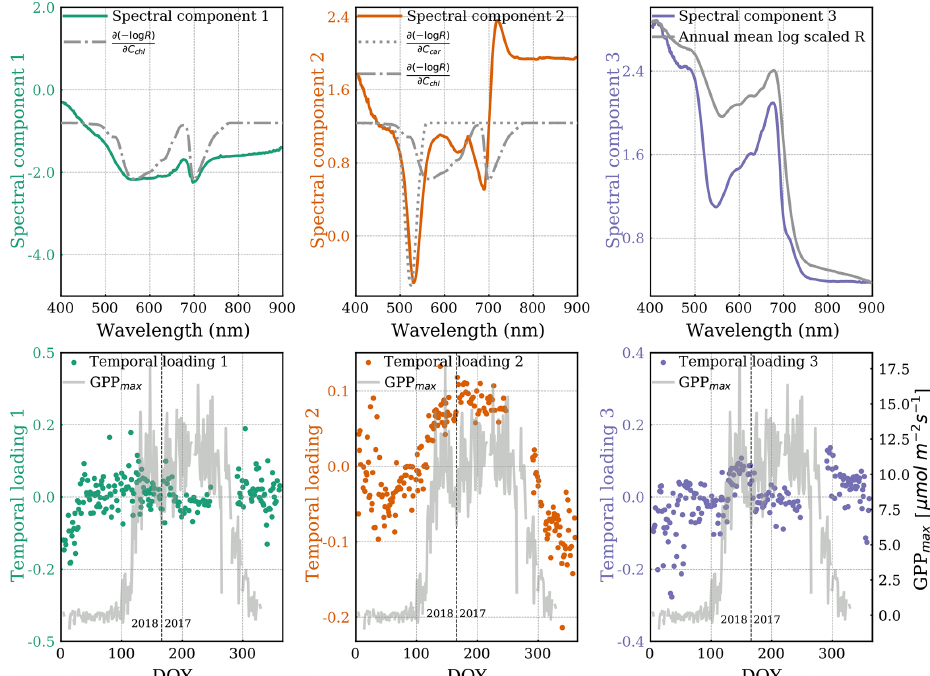
Figure 4. A set of three spectral components (top, colored) and corresponding temporal loadings (bottom, colored) from ICA decomposition. − log (R) The first spectral component is overlaid with the chlorophyll Jacobian ( ∂ , dashed–dotted), and the second spectral component is ∂C chl − log (R) overlaid with the carotenoid Jacobian ( ∂ , dotted). The third spectral component is overlaid on the annual mean shape of transformed ∂C car reflectance spectra. Temporal loadings are overlaid with GPP max (grey line). The axis of Jacobians is not shown because its magnitude is arbitrary here. The vertical dashed line divides the observations from DOY for the years 2017 and